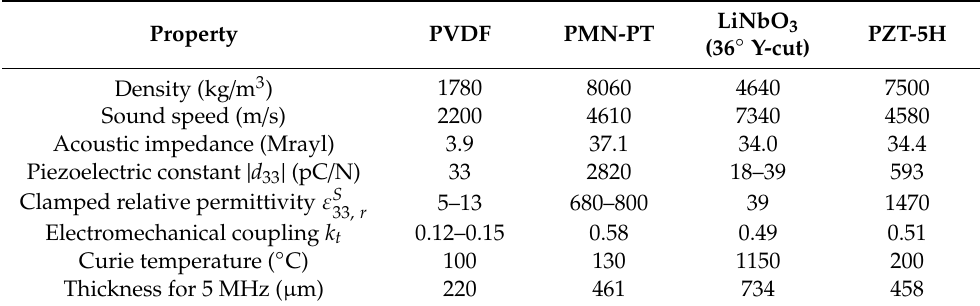
Figure 3. ( a ) Three-dimensional (3D) schematic of the typical structure of a thickness extension mode pMUT receiver. ( b ) Electrical model of the pMUT receiver. Table 1. Comparison of piezoelectric materials applied in thickness extension mode piezoelectric micromachined ultrasound transducers (pMUTs)